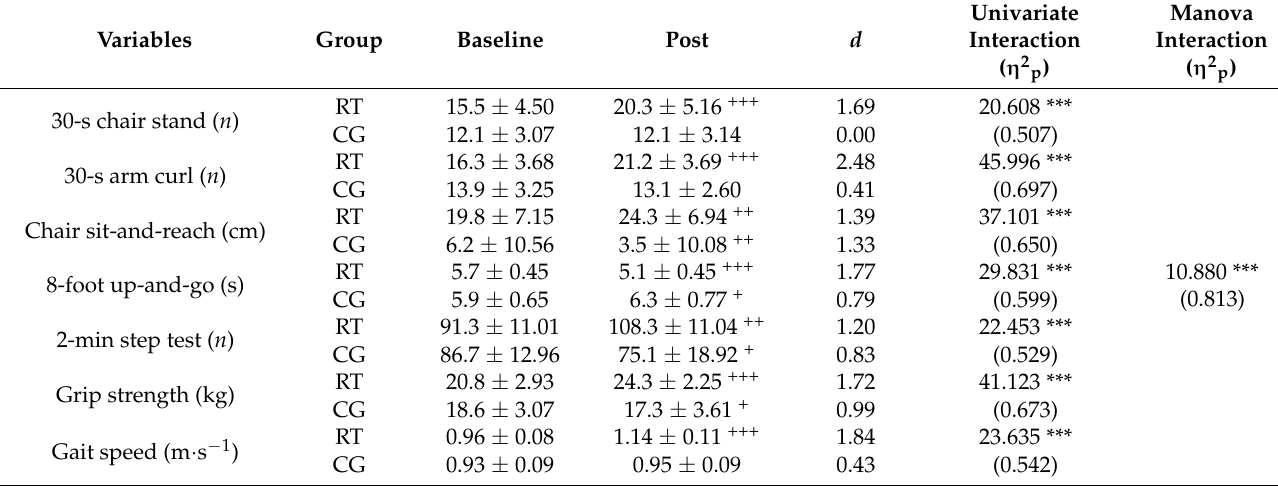
Table 5. Changes in functional fitness and physical performance during the